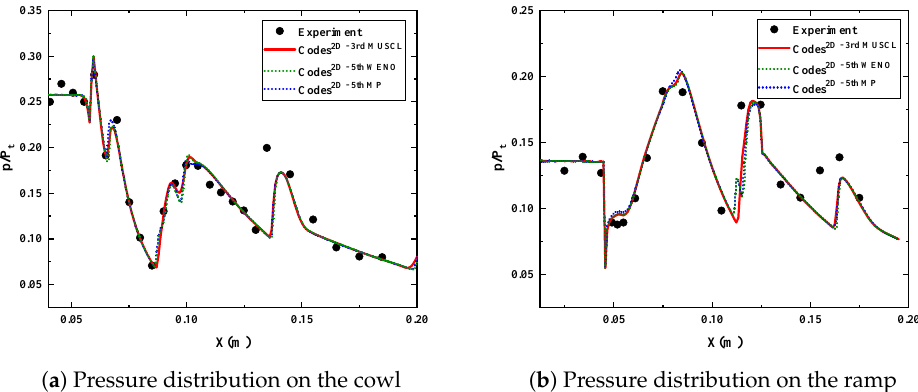
Figure 9. Comparison of simulation results for the three reconstruction schemes.